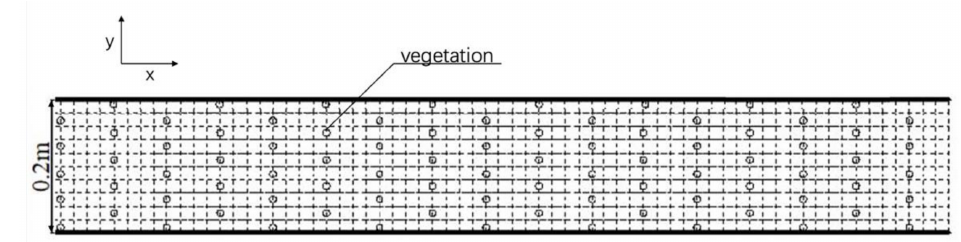
Figure 3. Top view of the